Question: Compose a caption that would accompany this figure in a paper.
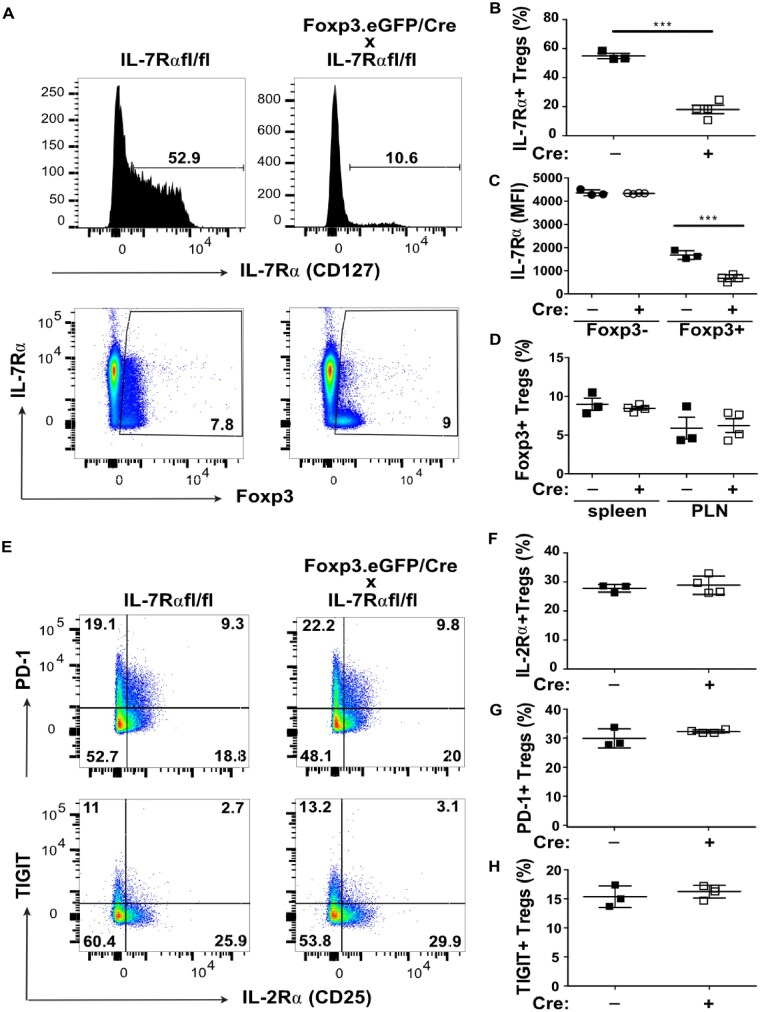
Answer: Cell-intrinsic loss of IL-7Rα expression does not alter the frequency and phenotype of Foxp3 + Tregs in young NOD mice. PLNs and spleens were harvested from 4-wk old NOD.IL-7Rα fl/fl and NOD.Foxp3.eGFP/Cre × IL-7Rα fl/fl mice and cell suspensions stained with fluorescently-labeled mAbs to detect Foxp3, IL-7Rα, CD25, PD-1 and TIGIT by flow cytometry. (A) Upper panels: Representative histograms show IL-7Rα expression in Foxp3 + Tregs from NOD.IL-7Rα fl/fl (Cre-) and NOD.Foxp3.eGFP/Cre × IL-7Rα fl/fl (Cre+) mice. Lower panels: Representative dot plots show frequencies (%) of Foxp3 + Tregs within the CD4 + T cell gate. Summary graphs show percentages of (B) IL-7Rα-expressing cells within the CD4 + Foxp3 + gate, (C) IL-7Rα expression levels (MFI) in Foxp3 neg vs Foxp3 + CD4 + T cells from both mouse strains ( n = 3–4), and (D) Foxp3 + cells within CD4 + T cells ( n = 3–4). (E) Representative dot plots show PD-1 and TIGIT expression vs CD25 expression gated on CD4 + T cells. Graphs show the percentages of (F) CD25 + , (G) PD-1 + , and (H) TIGIT + cells within the CD4 + Foxp3 + Treg gate from NOD.IL-7Rα fl/fl ( n = 3) and NOD.Foxp3.eGFP/Cre × IL-7Rα fl/fl ( n = 4) mice. *** = P < 0.001.